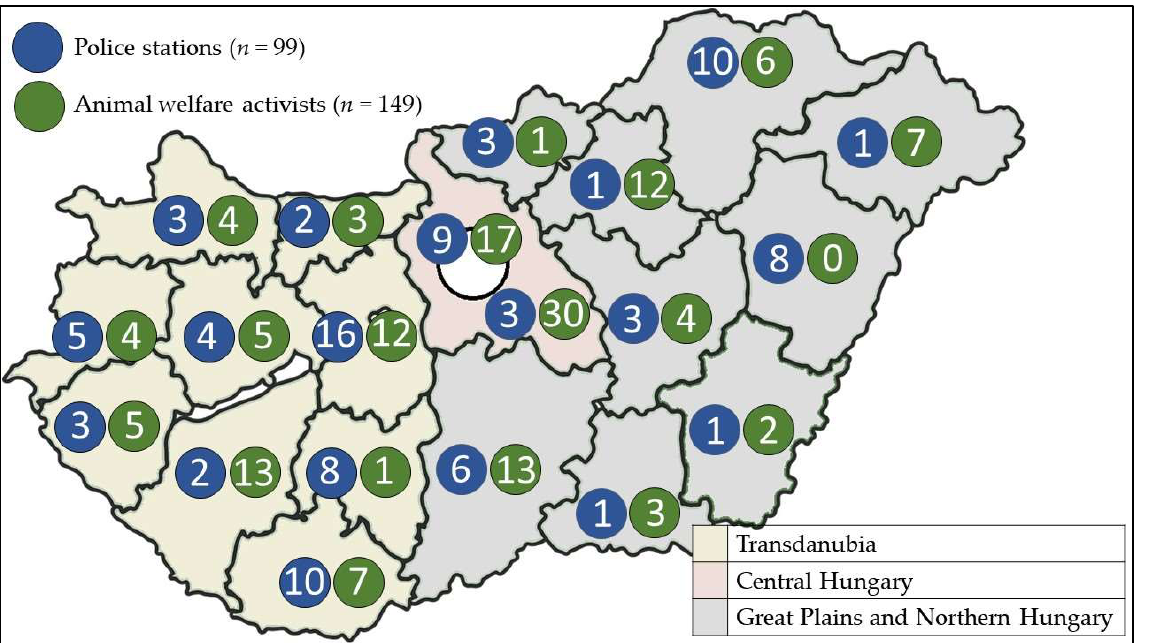
Figure 1. The territorial distribution of the number police stations and that of animal welfare activists filling out the questionnaire.